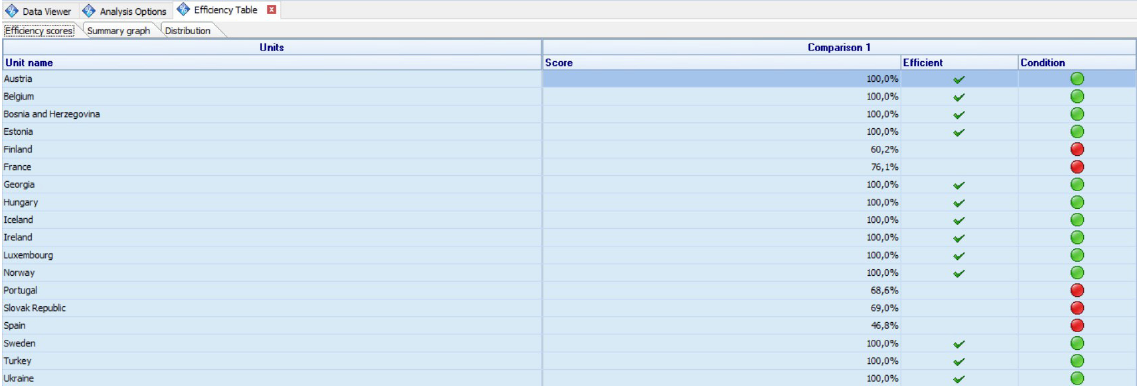
Figure 7. Efficiency of banking systems in 17 European countries and Ukraine as of 2020 calculated based on the DEA CCR model